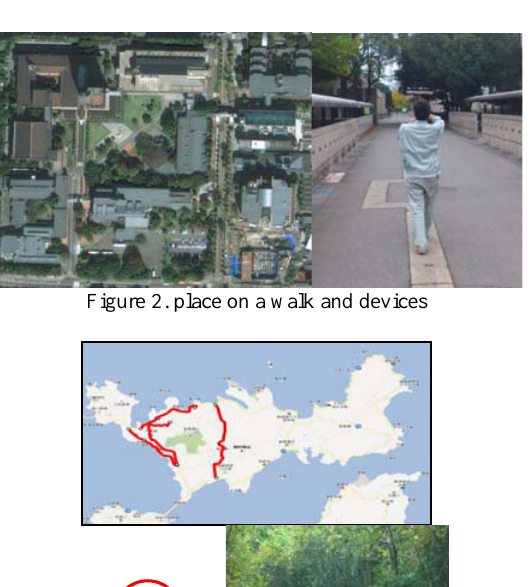
Figure 1. a fixed point and devices